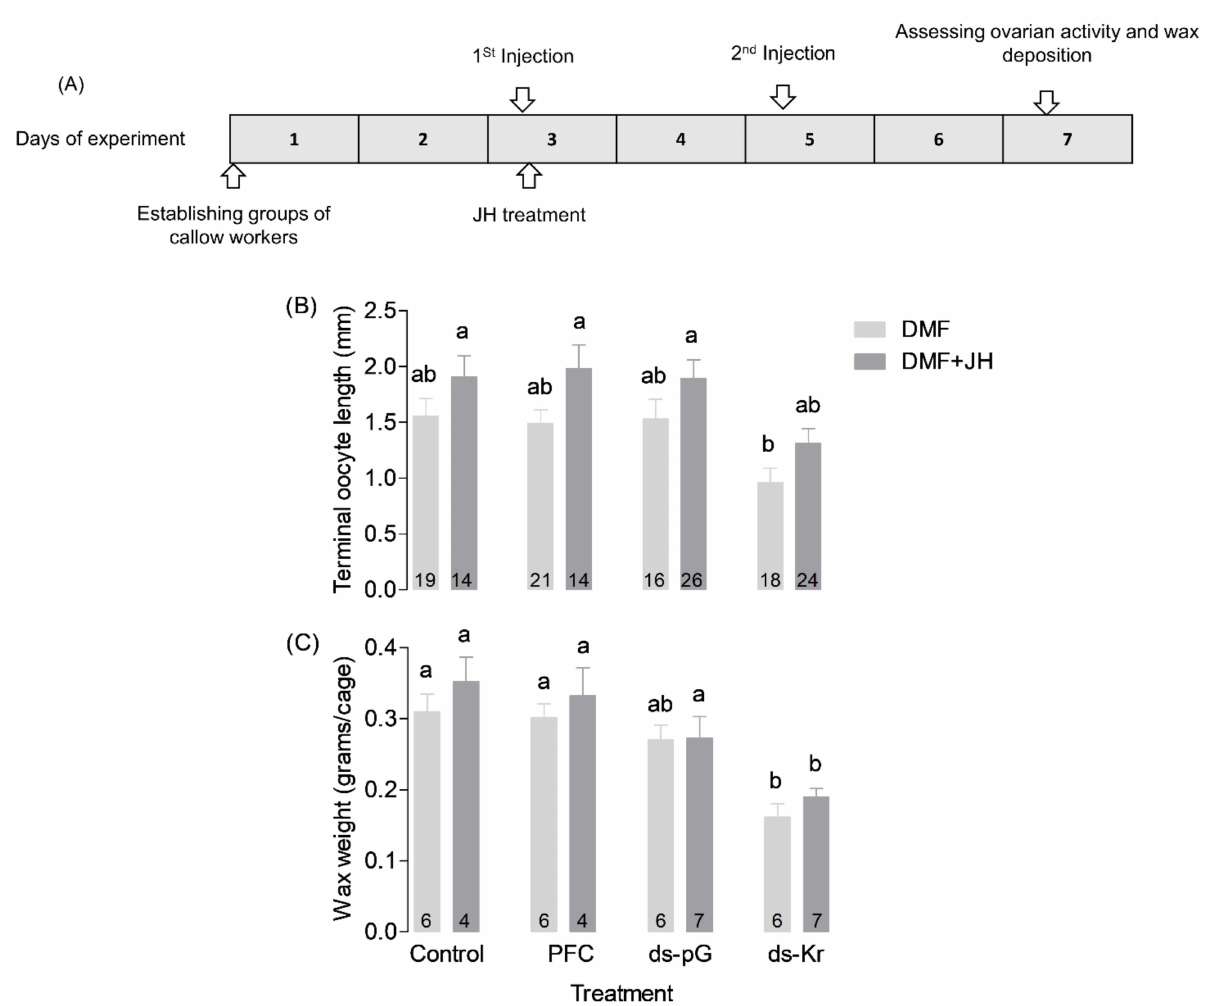
Figure 2. Treatment with JH-III could not fully recover the effect of Kr-h1 down-regulation. ( A ) Experimental outline. ( B ) Ovarian activity at seven days of age. ( C ) Total amount of wax deposited. Statistical analysis for the length of terminal oocyte was performed using square root transformed data, which fits normal distribution. Treatments marked with different small letters are statistically different in Two-way ANOVA followed by Holm–Sidak post-hoc tests. Numbers within bars show sample size, which is the number of bees in ( B ), and the number of cages in ( C ). Further details are shown in Figure